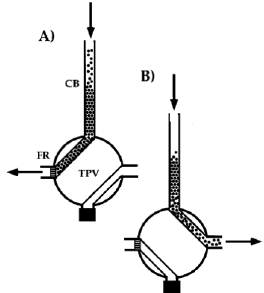
Figure 7. Schematic deposition of a renewable separation column (RSC) using a two valve [68] ( A ) column packing operation. ( B ) Disposal of separation material, CB: column body, FR: frit restriction, TPV: two-position valve.